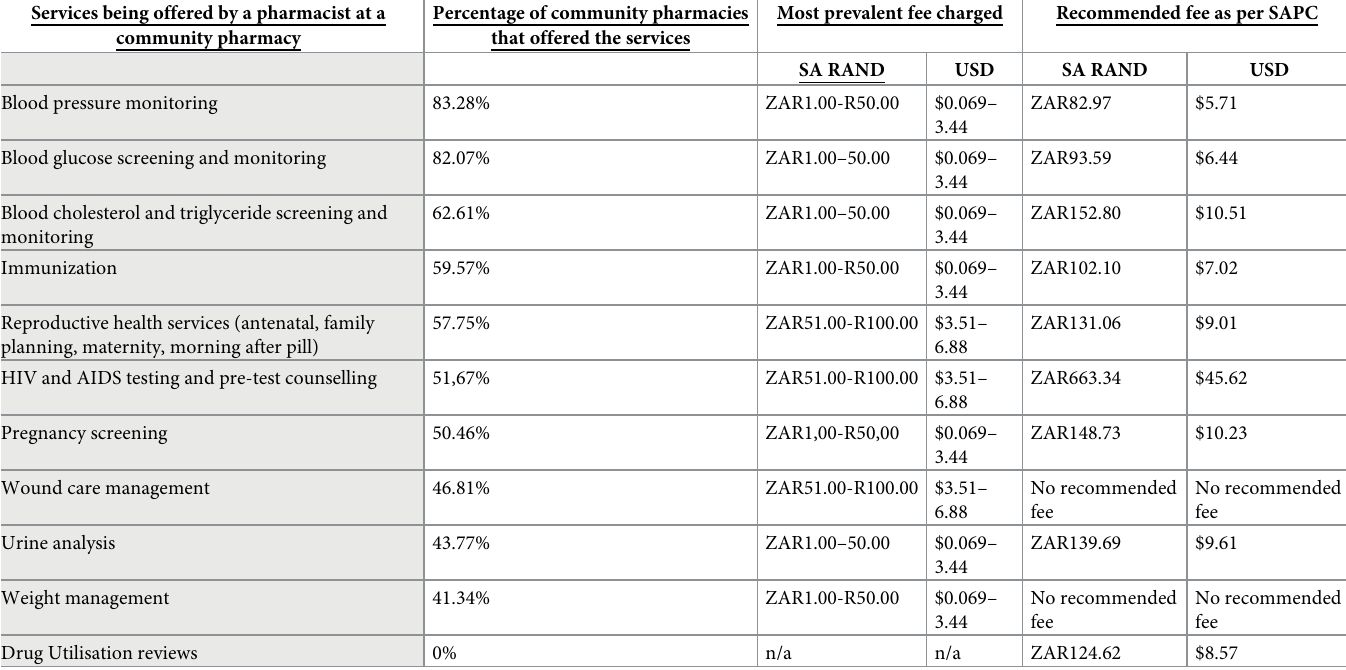
Table 1. Fees charged by community pharmacists’ verses the recommended fee by the SAPC for PHC services rendered. Services being offered by a pharmacist at a community pharmacy